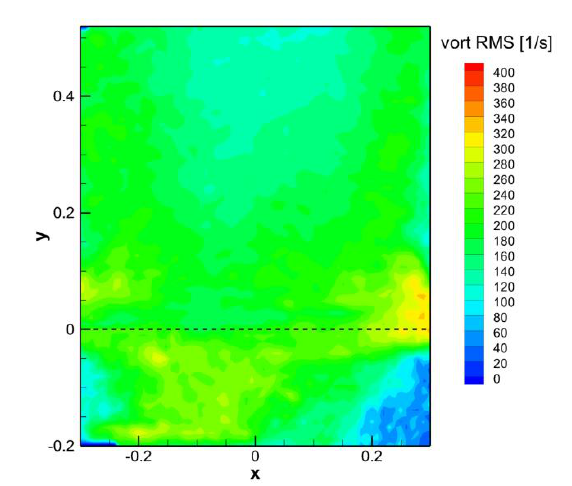
Fig. 18. Mean vertical velocity component distribution. Re = 1.5M.